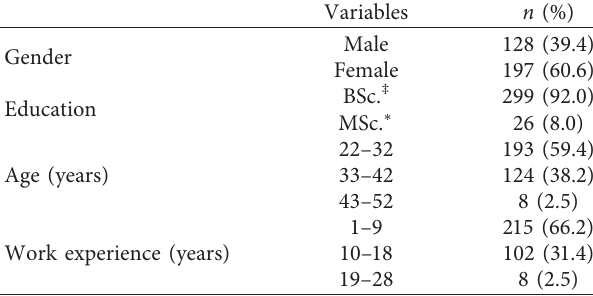
Table 1: Demographic characteristics of